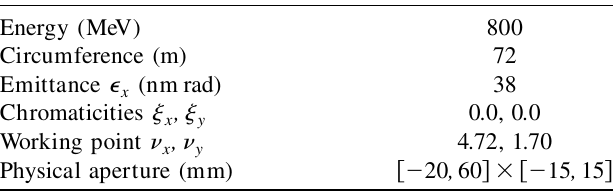
TABLE III. Super-ACO main parameters.